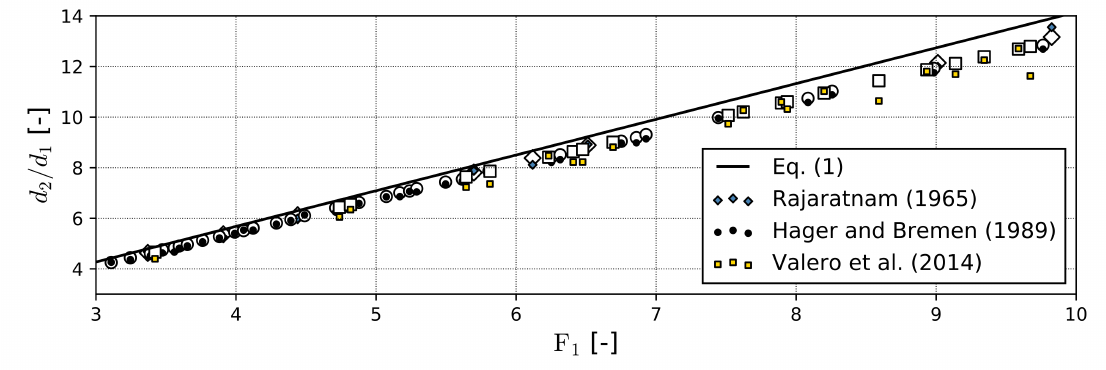
Figure 2. Experimental data (small solid markers) against theoretical predictions of Bélanger equation (Equation (1)) and Hager and Bremen theoretical formulation (big empty markers). Note that Hager and Bremen [35] formulation is Reynolds number and width/depth ratio dependent, and thus a solid line cannot be traced. Median absolute relative difference between Hager and Bremen [35] formulation and